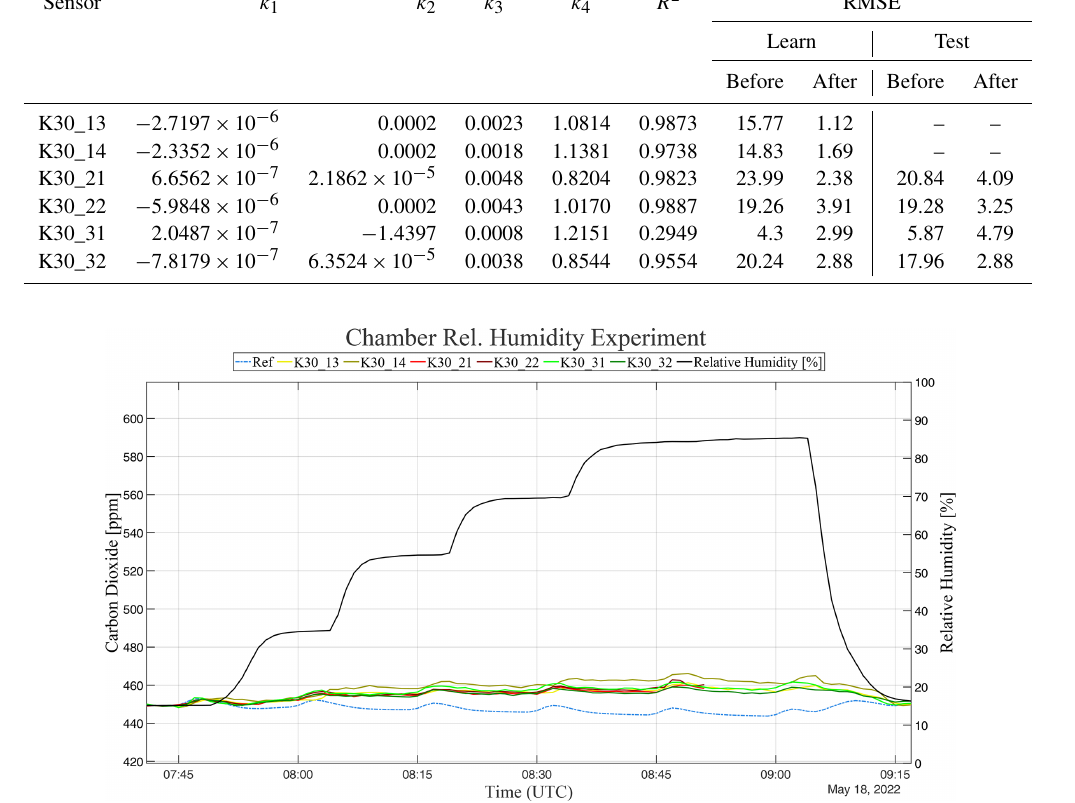
Figure 7. Time-series data for the chambered relative humidity experiment. The solid black curve represents the relative humidity inside the chamber. The yellow, green, and red curves represent the CO 2 values reported by the test sensors. The dashed blue curve represents the CO 2 values reported by the reference